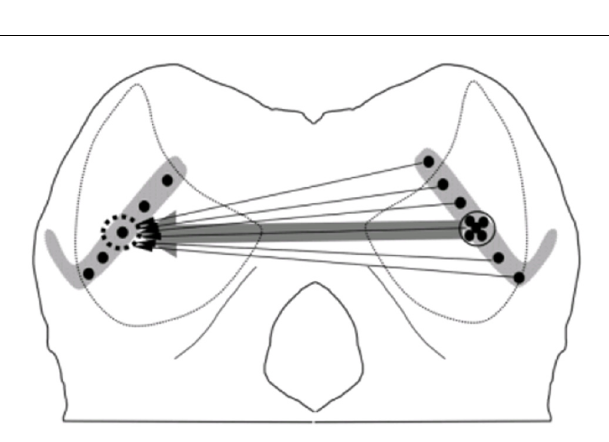
FIGURE 3 | Schematic wiring diagrams of the commissural connections. In the central nucleus of IC (ICc), the retrograde labeling of neurons demonstrated that an injection into one point on the lamina (dotted circle, left IC) retrogradely labeled neurons over the whole extent of the contralateral lamina, consistent with a divergent pattern of connections (thin arrows).The density of the projection is centered on a point matching the position of the tracer injection which is consistent with a point-to-point-weighted wiring pattern (thick arrow; Malmierca etal.,